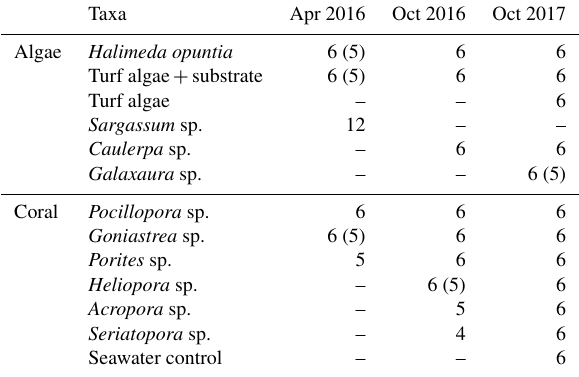
Table 1. Taxa measured in on-ship incubation experiments includ- ing the number of replicate specimens measured (one specimen per incubation core). Some of the specimens were not included in the final analysis due to sampling errors or due to O 2 not increasing dur- ing both of the light intervals or not decreasing during both of the dark intervals; the resulting number of specimens used are shown in